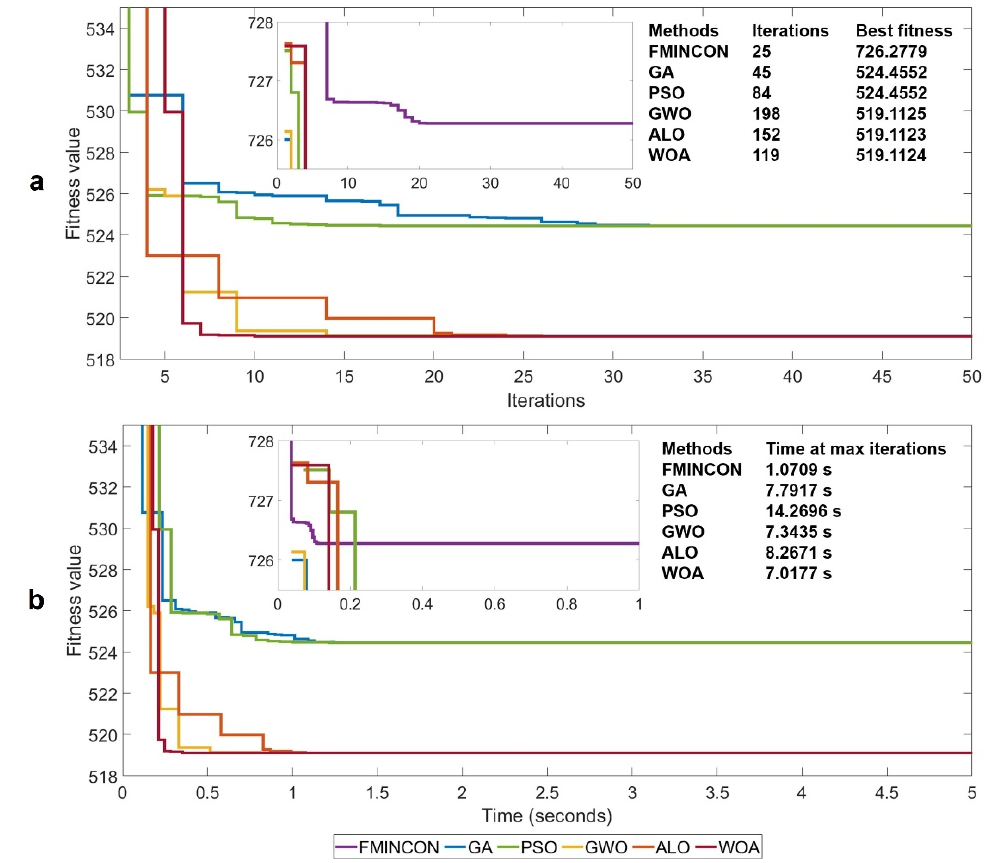
Figure 10. Convergence characteristics of algorithms based on: ( a ) iterations ( b ) simulation time.